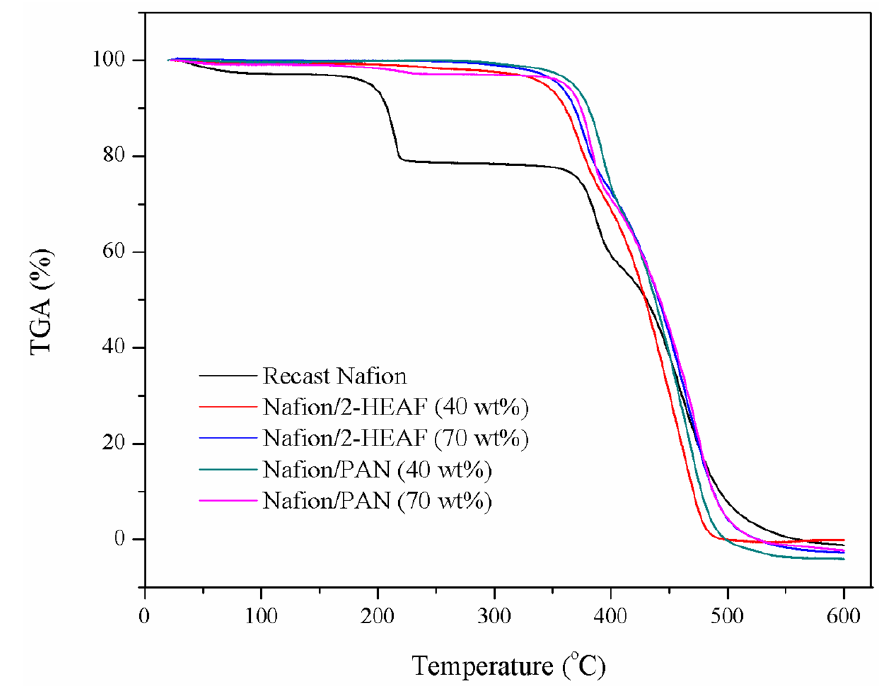
Figure 4. Thermal stability tests for all the membranes.